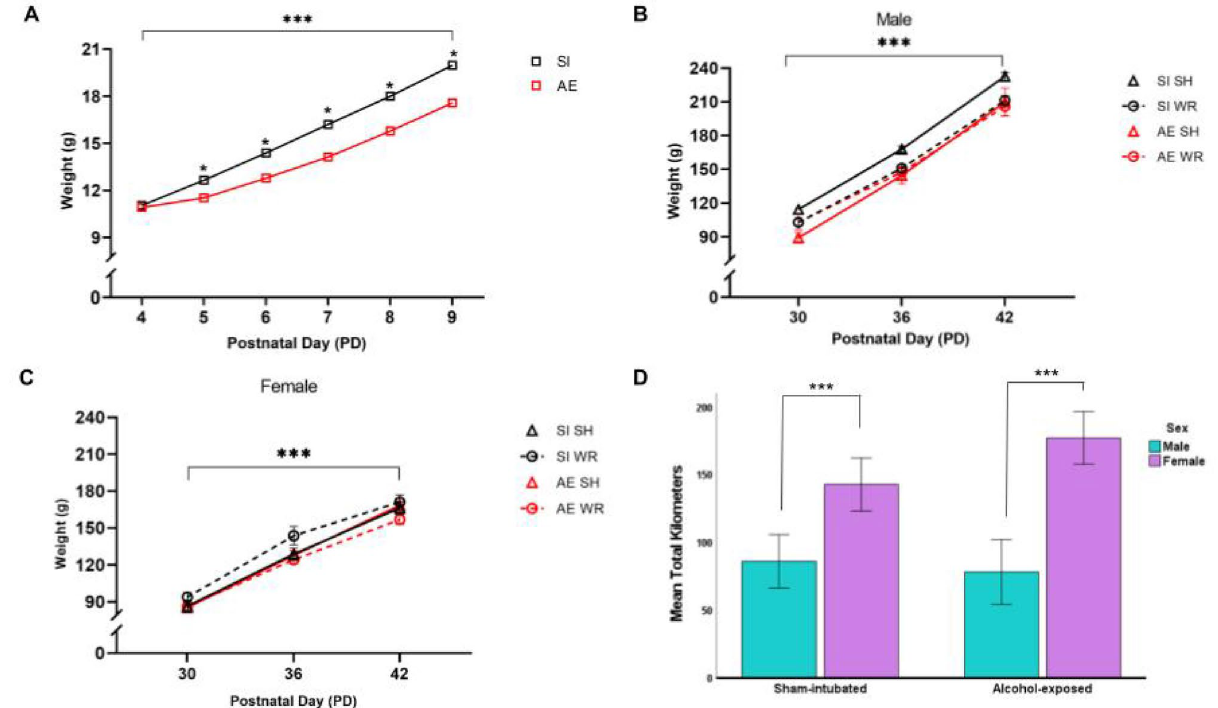
Figure 3. ( A ) Daily recorded mean body weight of AE (red) and SI (black) rat pups during the postnatal treatment period which targets the BGS. Mixed repeated measures ANOVA indicates that all rats gained weight across the treatment period (*** p < .01). Cross-sectional analysis shows that AE pups weighed less than SI pups from PD five through nine during the treatment period (* p < .01). Data were collapsed across sex as there was no main effect or interaction of weight gain with sex. ( B – C ) Recorded mean body weight of male and female AE and SI rats from both intervention groups (WR and SH control) before, during, and after the intervention period. Mixed repeated measures ANOVAs indicate that all rats gained weight across the adolescent intervention period (*** p < .001). There were significant main effects of intervention exposure and sex wherein intervention-exposed females gained the least amount of weight across the adolescent intervention period. Cross-sectional analysis shows that AE pups weighed less than SI rats at each time point during the intervention period. D) Average total kilometers run recorded from WR cages containing same-sex AE or SI rats. Female rats ran the most during the adolescent intervention period. There was no main effect of postnatal treatment